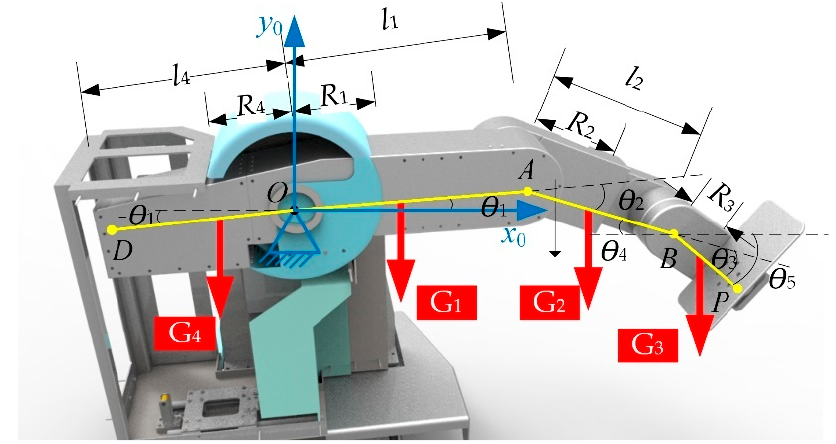
Figure 5. Leg model of lower limb rehabilitation robot.